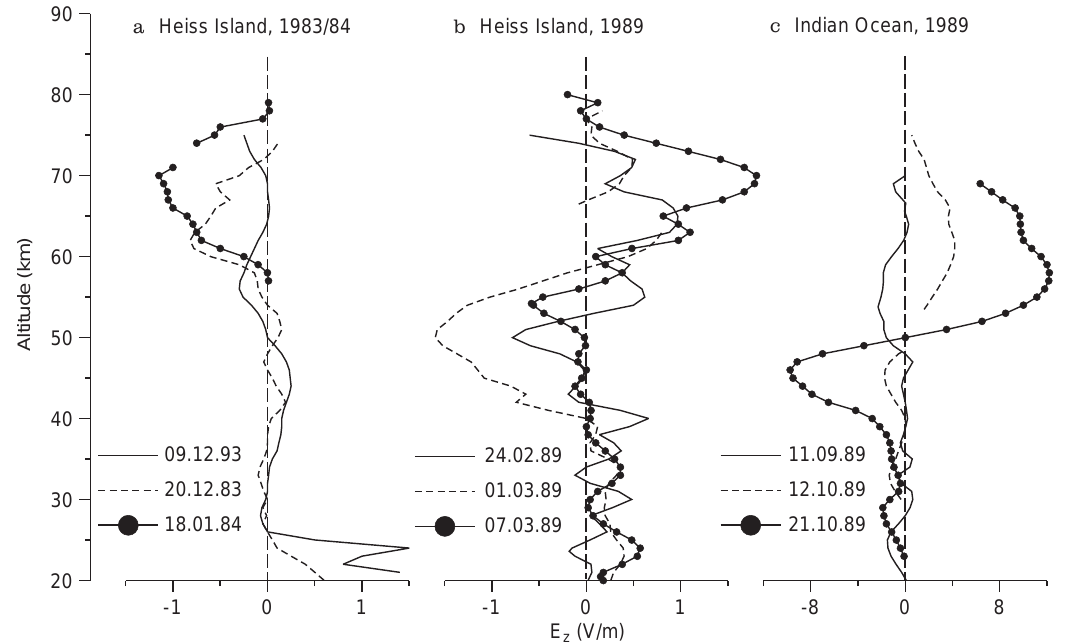
Fig. 1. The vertical electric fields measured above a, b Heiss Island (80 : 6 (cid:14) N) and c the Indian Ocean ( (cid:24) 50–60 (cid:14) S)